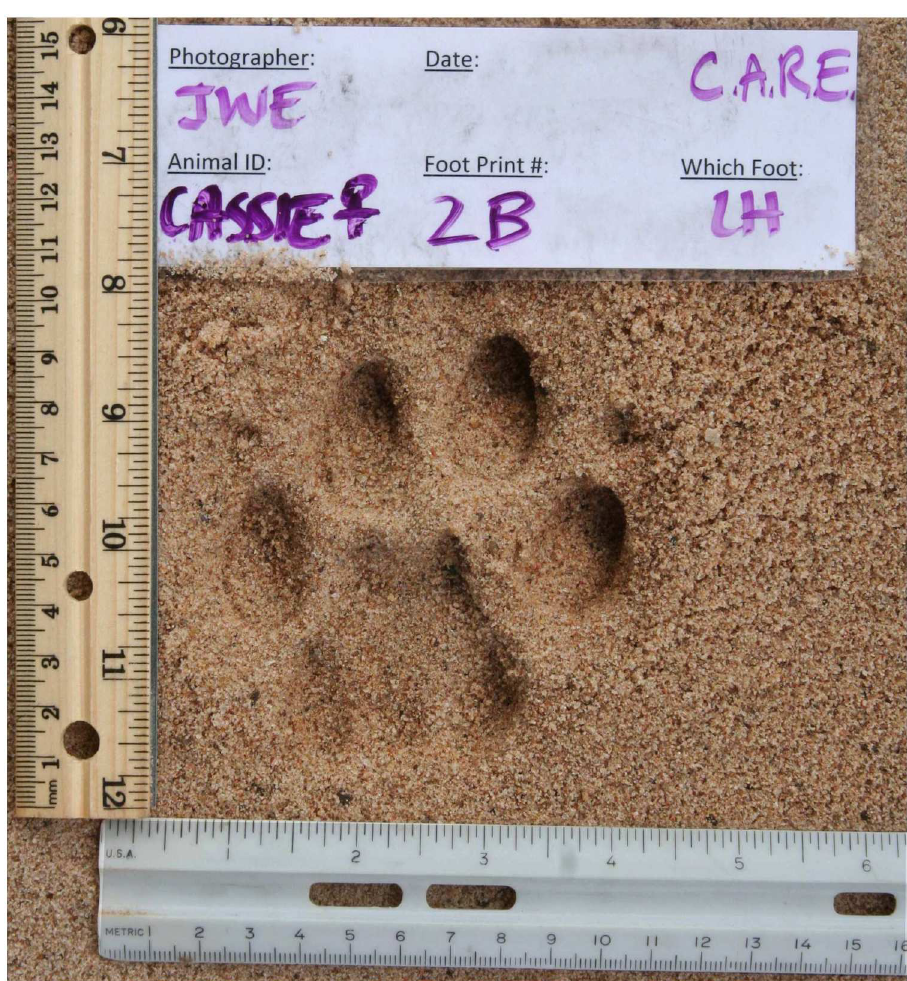
Fig 3. An excellent quality puma footprint, photographed to the FIT protocol. A metric scale is placedto the left and posterior edge of the footprint, and a photo ID slip containing details of the footprint and image is included. The image is taken from directly